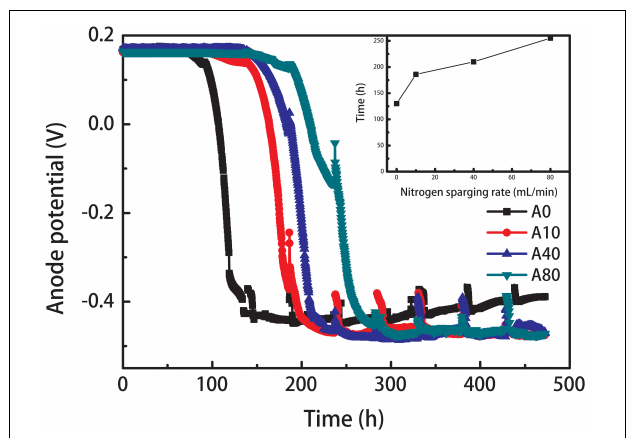
FIGURE 1 | Anode potential of the anode biofilms enriched with different nitrogen sparging rates during startup. The inset shows the relationship between the nitrogen sparging rate and the time required for the anode potential reaching the stationary potential around –420 ± 20 mV.